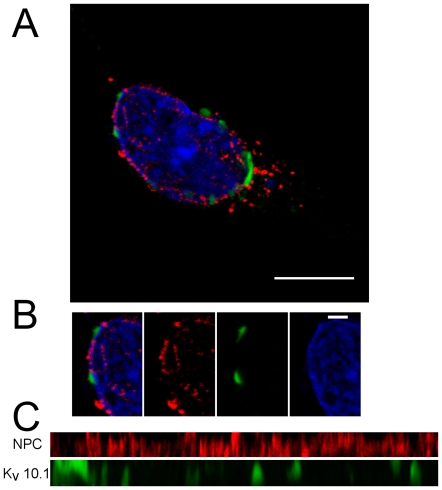
Perinuclear KV10.1 is located to NPC-free islands.A. Representative picture of a CHO cell transiently expressing KV10.1 and stained with anti-NPC antibodies (red) and anti-KV10.1 antibodies (green). In the perinuclear region marked by the boundary of DNA stained by DAPI (blue), KV10.1 is excluded from the region containing NPC. Scale bar: 10 µm B. Enlargement of a perinuclear region from the same cell. Scale bar: 2 µm C. The perinuclear region is shown straightened to allow comparison between red and green fluorescence.